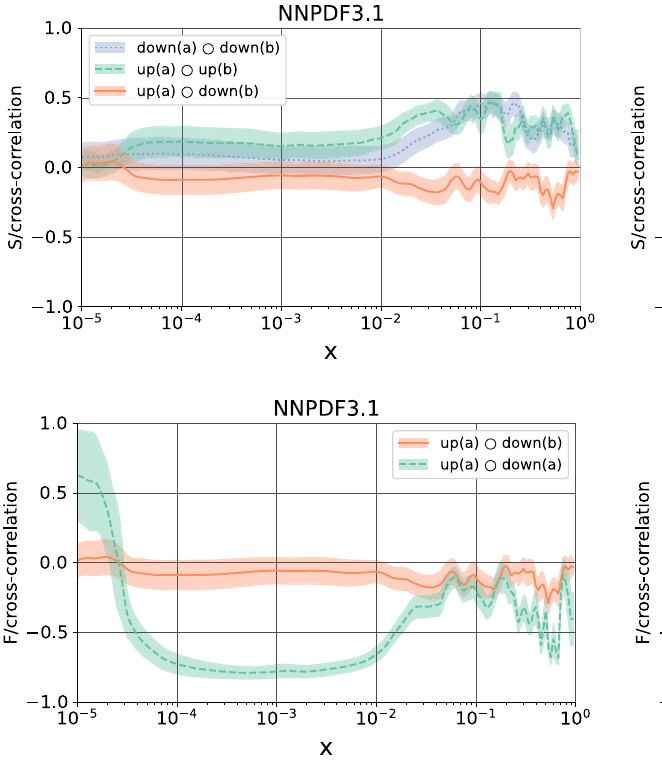
for the NNPDF3.1 (left) and the NNPDF4.0 methodology (right). In all plots a , b denote two distinct sets of correlated replicas (i.e. fitted to the same underlying data), so a (cid:7) b denotes the case in which the replicas are correlated but distinct while a (cid:7) a denotes the case in which the replicas are